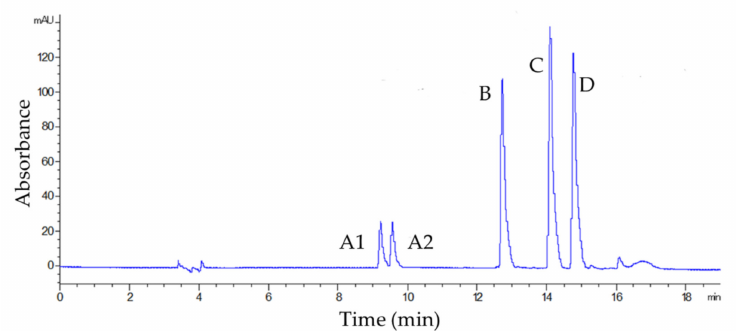
Figure 1. Chromatogram at 254 nm related to analysis of the mix of 10 mg L − 1 HAD standards aloin B ( A1 ), aloin A ( A2 ), aloe emodin ( B ), emodin ( C ), and danthron ( D ).